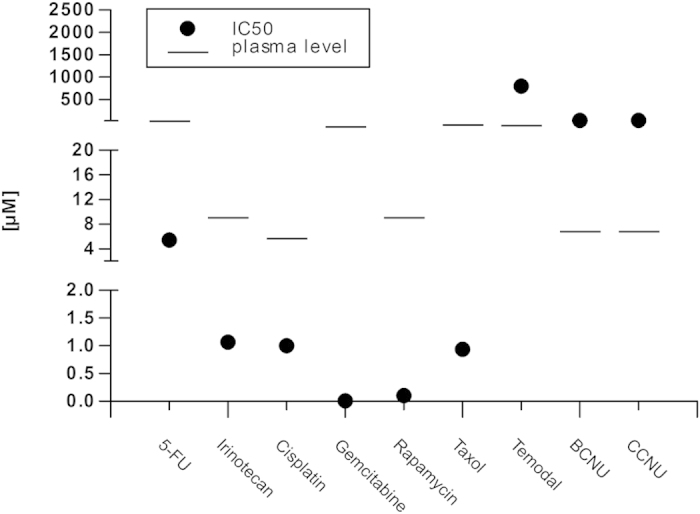
Drug response.Response to therapeutic agents is given as IC50 value (black dot) and clinically evident patient plasma levels are indicated by a line. Therapeutic agents used are listed on the x-axis. On the y-axis, concentrations of the therapeutic agents are displayed in μM using a segmented y-axis.